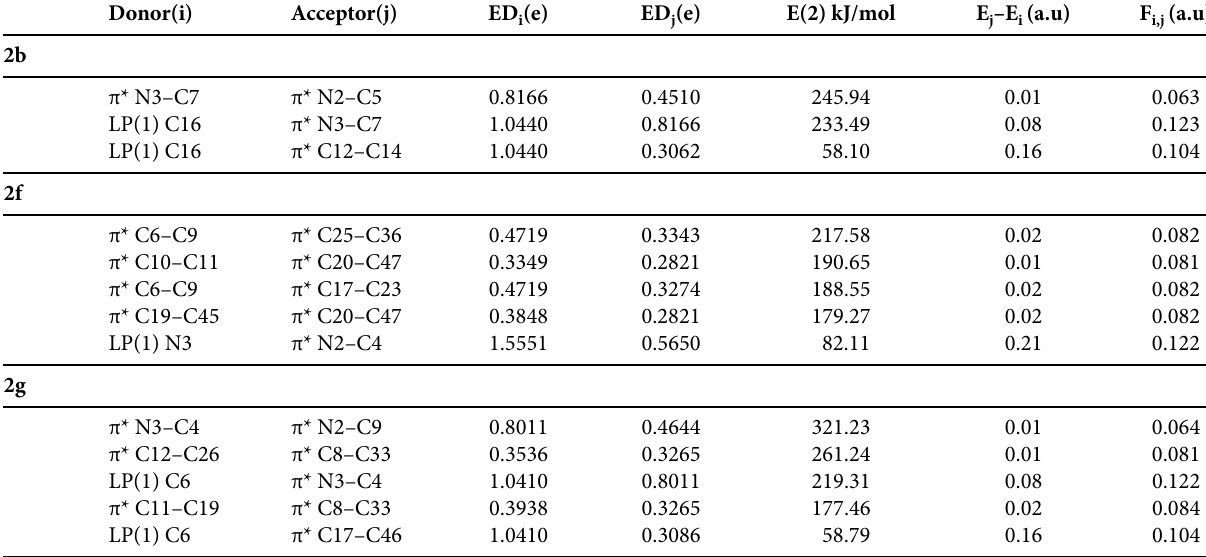
Table 4. The Second Order Perturbation Theory Analysis Results of the Fock Matrix in NBO Basis for 2b , 2f and 2g at B3LYP/6-31G* level of the theory.